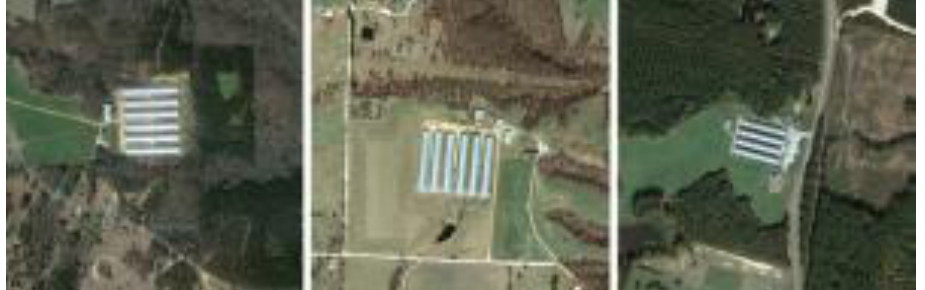
Figure 2. Aerial photographs of CAFOs demonstrate lack of geographic specificity. From left to right: poultry farms in Alabama, Arkansas and Virgina